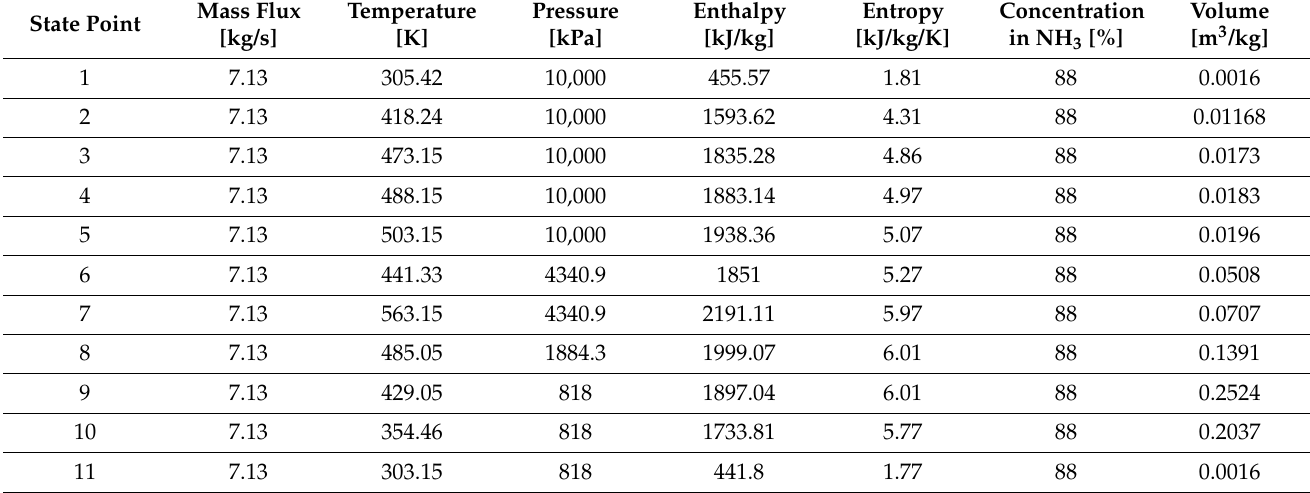
Table 8. Thermodynamic properties of KCA system points.